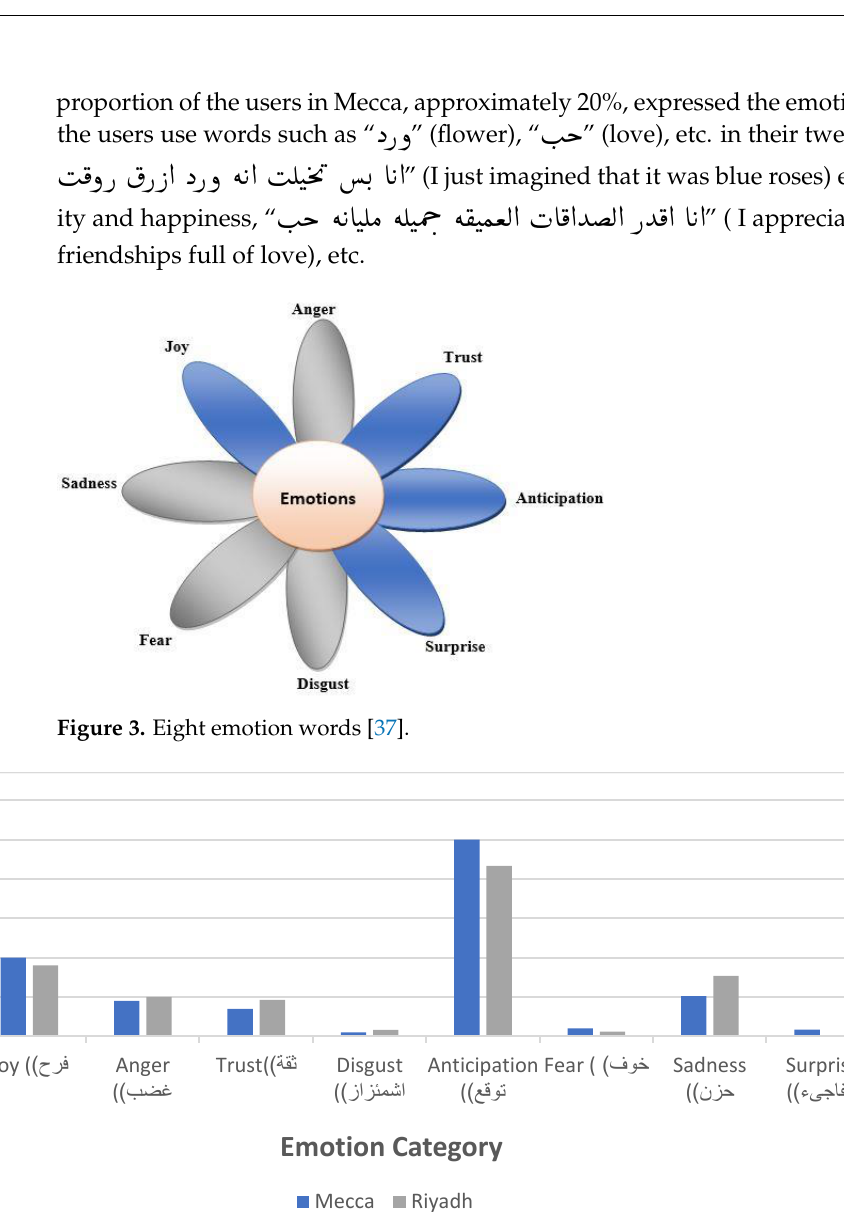
Figure 4. The proportion of user moods across Riyadh and Mecca.